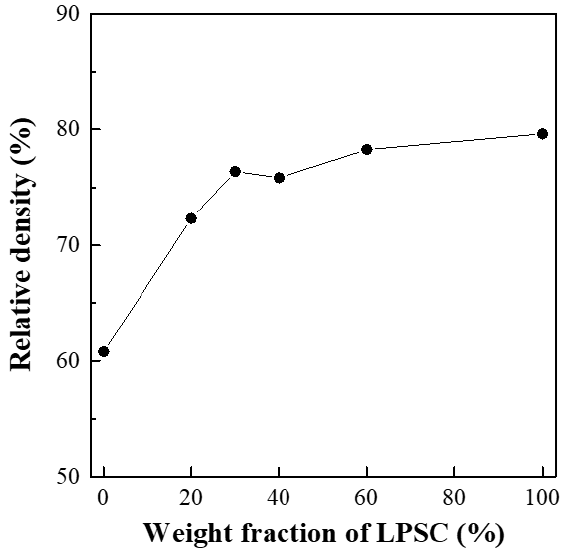
Figure 2. Relative densities of LLZO-LPSC composite electrolytes.